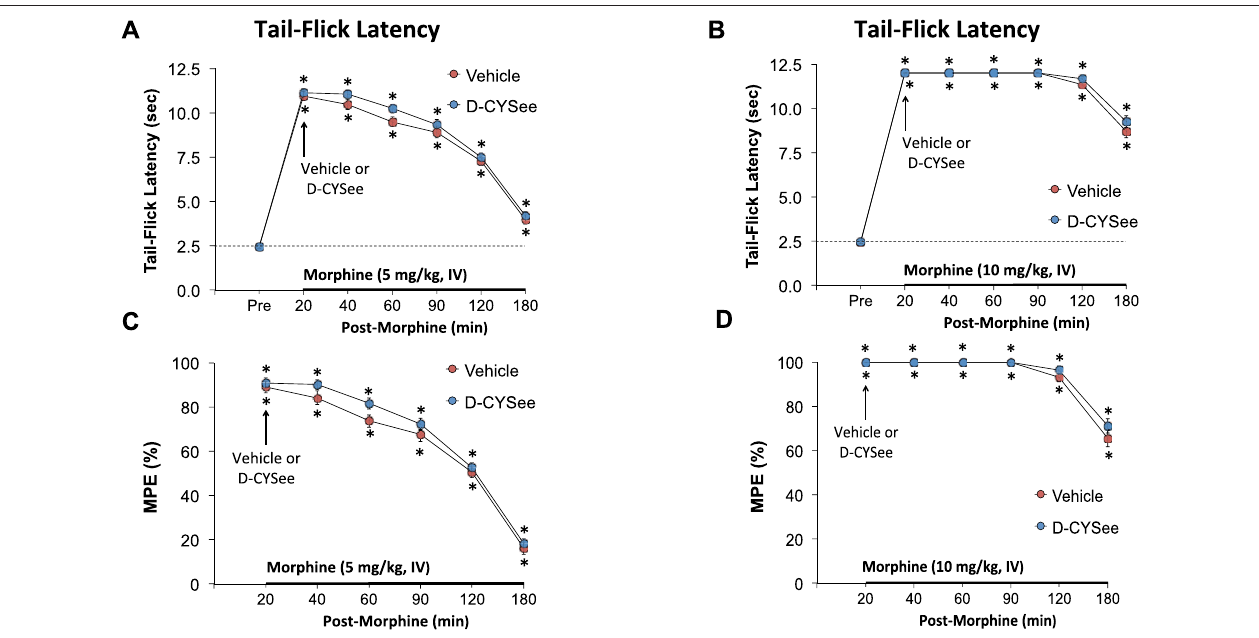
FIGURE 9 | Tail- fl ick latencies elicited by intravenous injection of 5 mg/kg (Panel (A) ) or 10 mg/kg (Panel (B) ) of morphine in freely-moving rats that received injectionsofvehicle(VEH(saline),IV)orD-CYSee(500 μ mol/kg,IV)20 minaftertheinjectionofmorphine.Panels (C,D) displaythedataaspercentagemaximumpossible effect (%MPE). The data are shown as mean ± SEM. There were 6 rats in each group. * p < 0.05, signi fi cant change from pre-values. There were no between group comparisons at any time-point ( p > 0.05, for all comparisons).